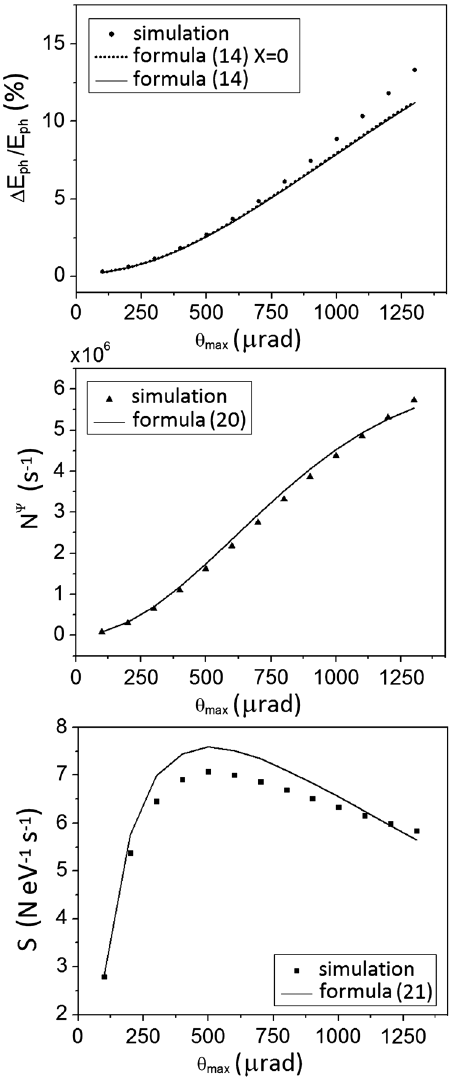
=E FIG. 3. Case C: Δ E (%) value from CAIN simulation vs ph ph formula (14) without and with X correction. N Ψ (s − 1 ) number of : simulated values vs formula (20). S (N eV − 1 s − 1 ) photons in θ max spectral density per shot ( r ¼ 1 ): simulated values vs formula (21).